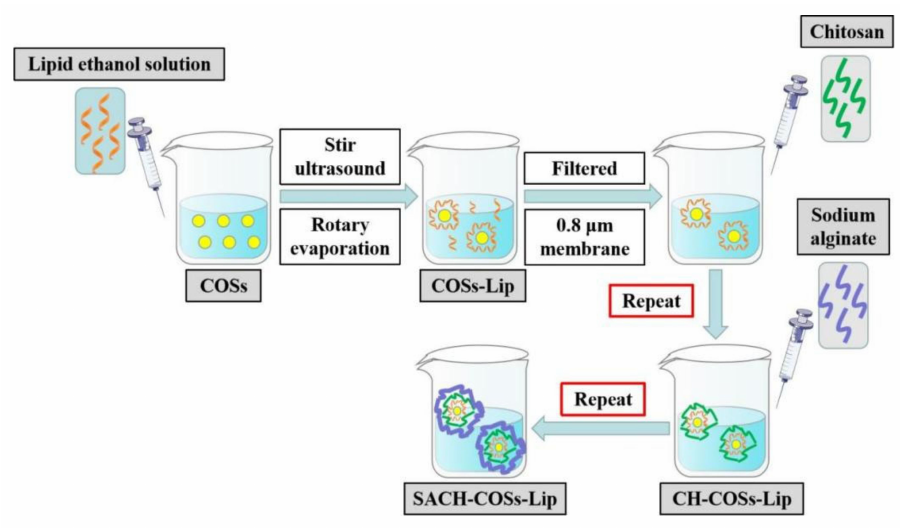
Figure 1. Preparation of